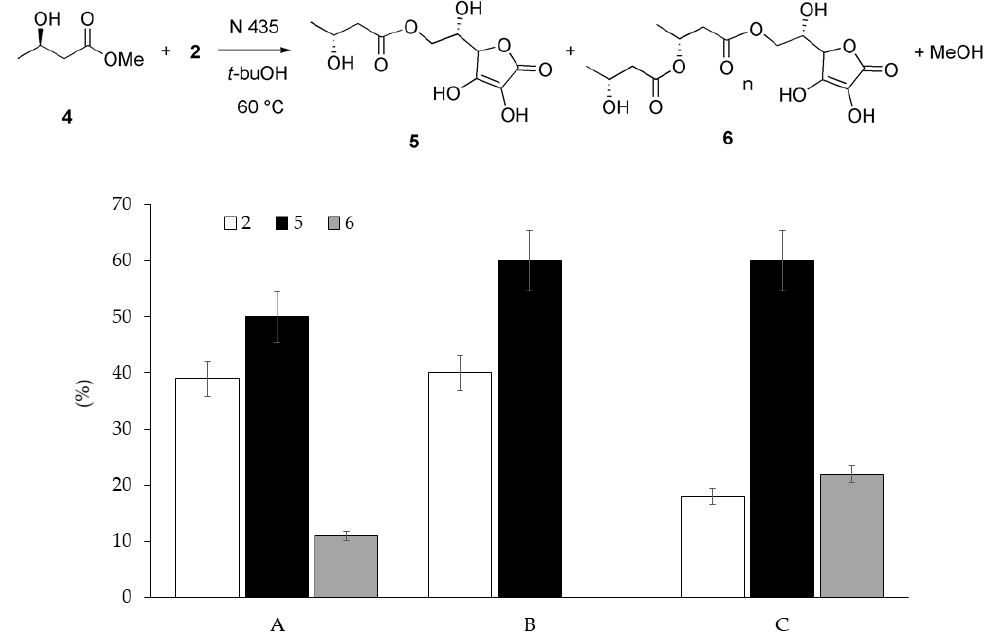
Figure 1. N-435-catalyzed synthesis of 6- O -(R)-3-hydroxybutyryl ascorbic acid 5 : with one, two, and three equivalents of the acylating agent 4 (conditions A, B, and C, respectively). Reaction conditions: 2 (0.57 mmol), 4 (0.57 or 1.14 or 171 mmol), t -butanol (8 mL), 5 Å molecular sieves (0.8 g), N 435 (80 mg). The composition of the crude reaction mixtures was determined by 1 H-NMR analysis. The values are the means of three independent experiments.